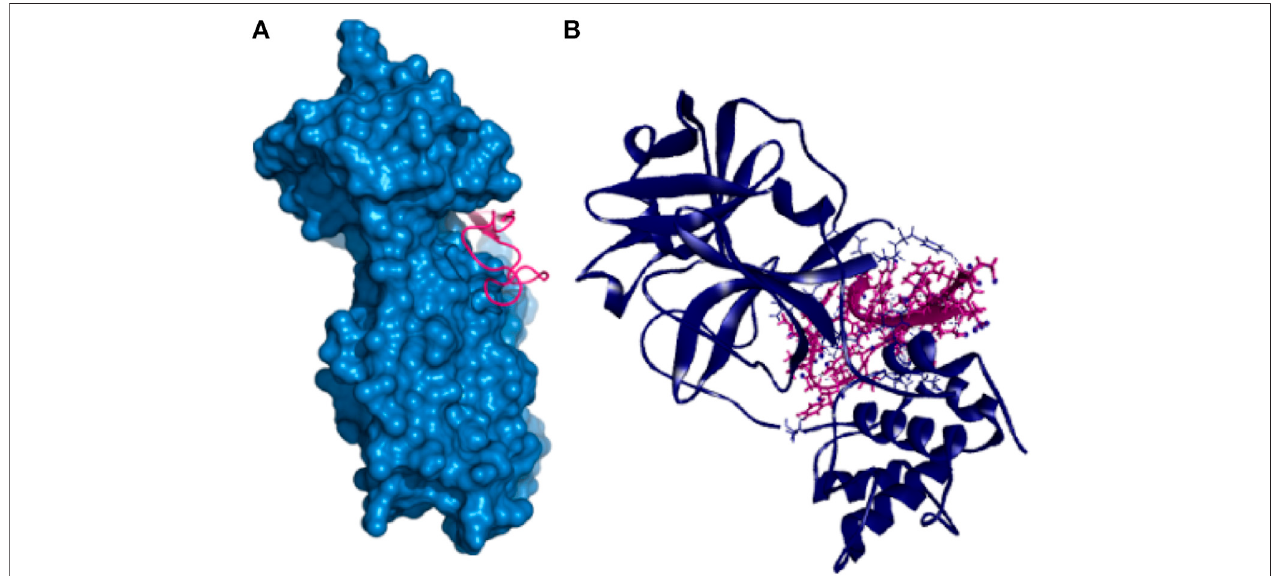
FIGURE 3 | Non-covalent interactions of main protease and P41 peptide molecule (A , B) .